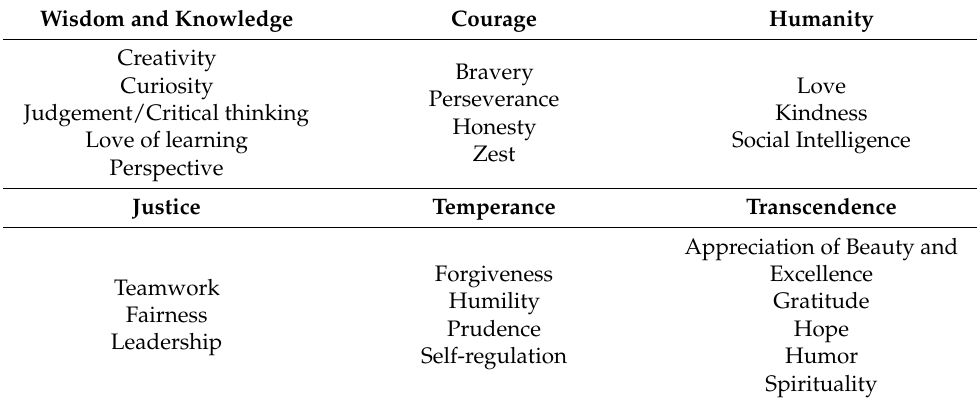
Table 1. Overview virtues and